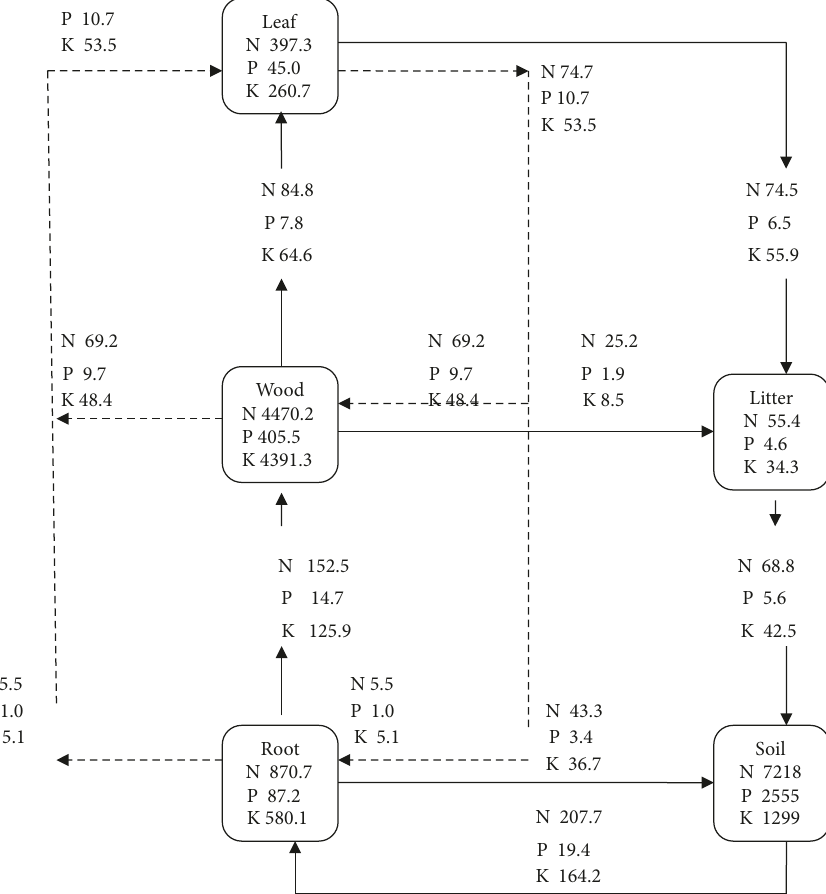
Figure 3: Model showing the distribution and cycling of nutrients, N, P, and K in undisturbed forest stand of moist tropical forest of Sunsari district eastern Nepal. Values inside compartments represent nutrient stocks (kg ha – 1 ). Internal recycling is represented by the broken lines. Net annual fluxes between compartments are representedas arrows (kg ha – 1 yr – 1 ). The root compartment includes coarse as well as fine roots. The wood compartment also includes aboveground nonleaf part of herbs (especially of the perennial forbs).